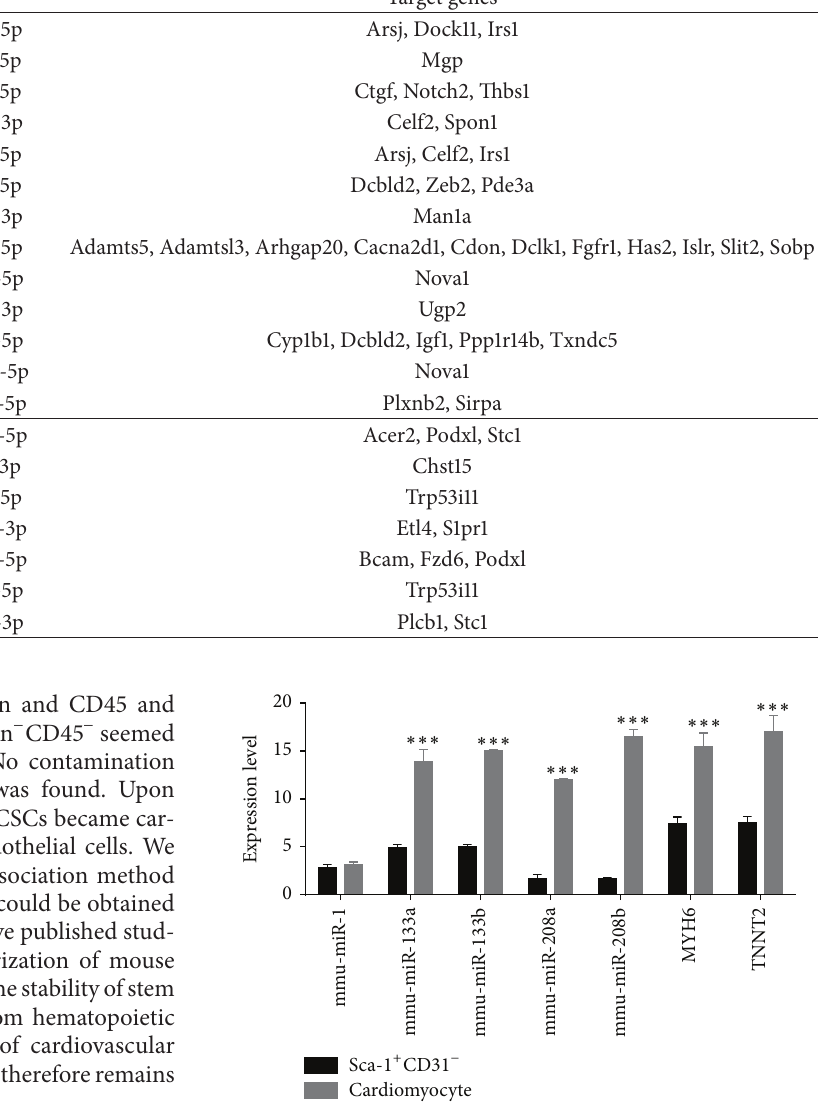
characteristics. Islet-1 (ISL-1), a marker of the secondary heart field [25], was not detectable in Sca-1 + CD31 − and Sca-1 + CD31 + CSC cells, and TBX5, a marker of the primary heart field [24], was detected, with expression of TBX5 higher in Sca-1 + CD31 − than Sca-1 + CD31 + . The cardiac- specific transcription factors GATA-4, GATA-6, and MEF2C were all expressed in Sca-1 + CD31 − and Sca-1 + CD31 + CSC cells with higher expression of GATA-4 and